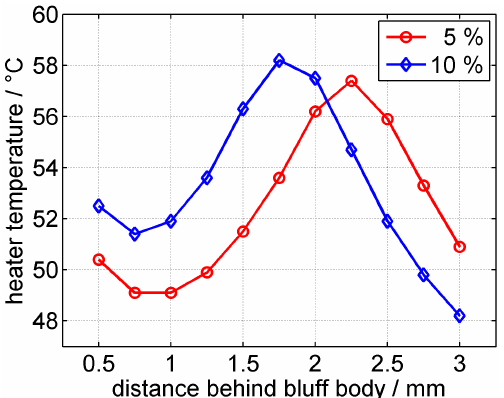
Figure 13. Measured temperature increase (averaged over the last 2s of every heat pulse) of the individual heaters of the array for different flow rates of water.